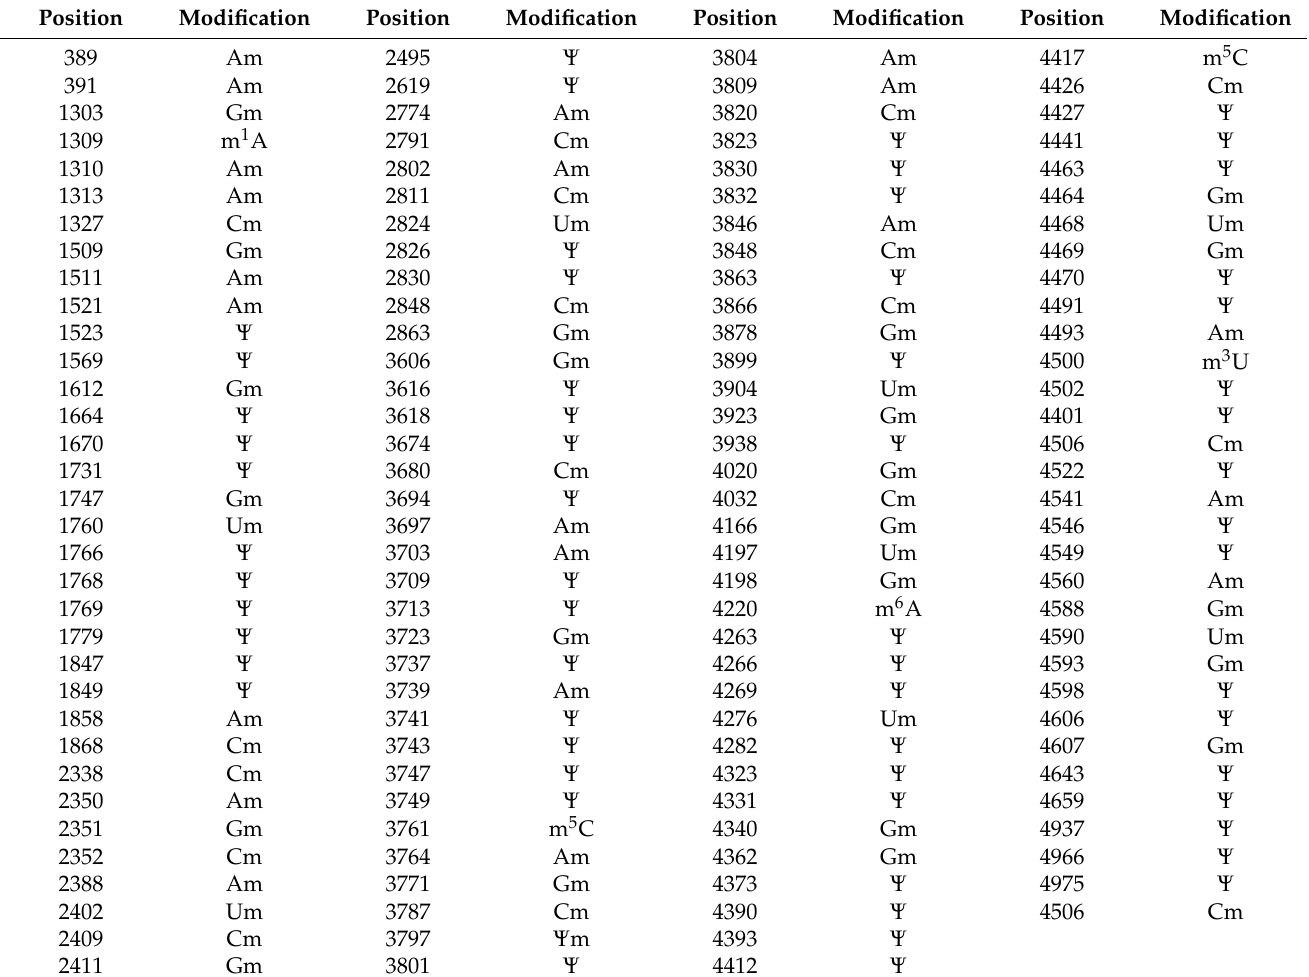
Table 3. Position and type of RNA modifications that have been detected in human 28S